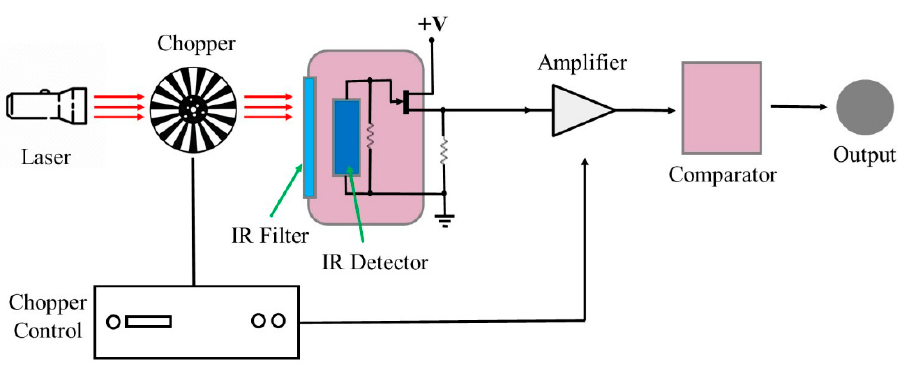
Figure 3. Schematic of pyroelectric sensor based on infrared heating.